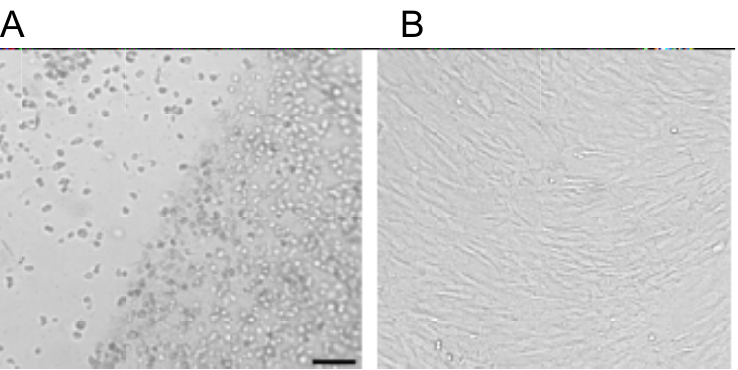
Figure 5. DPSC in fibrin gel ( A ) at day 5 after seeding. Some cells left the gel where cells were grown at a high density. The fibrin gel was removed from the Petri dish, and ( B ) in 3 days, the cells that left the gel expanded to 100% confluency. The scale bar: 100 mkm.